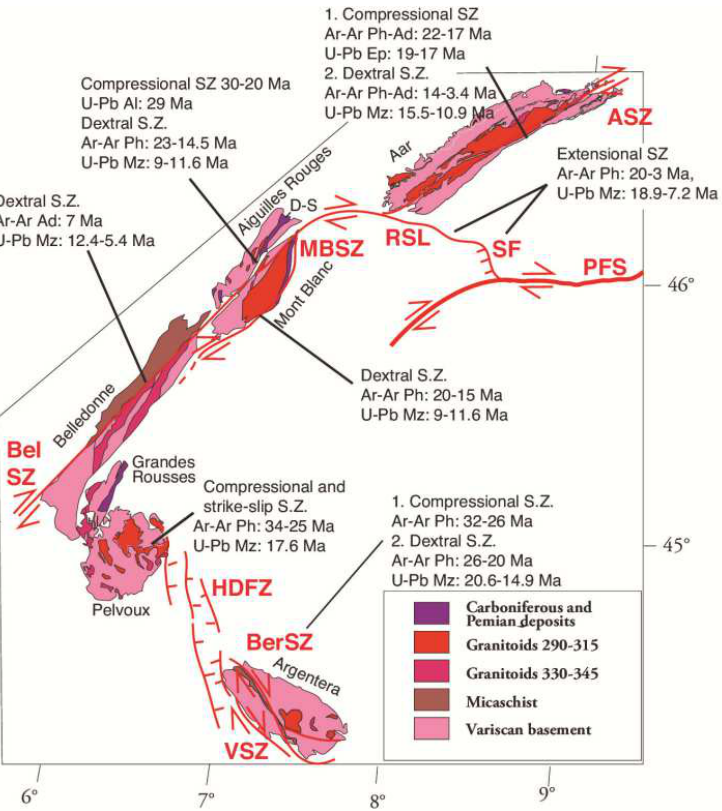
Figure 5. Compilation of Ar–Ar on phengite and U–Pb on allanite/epidote/monazite ages